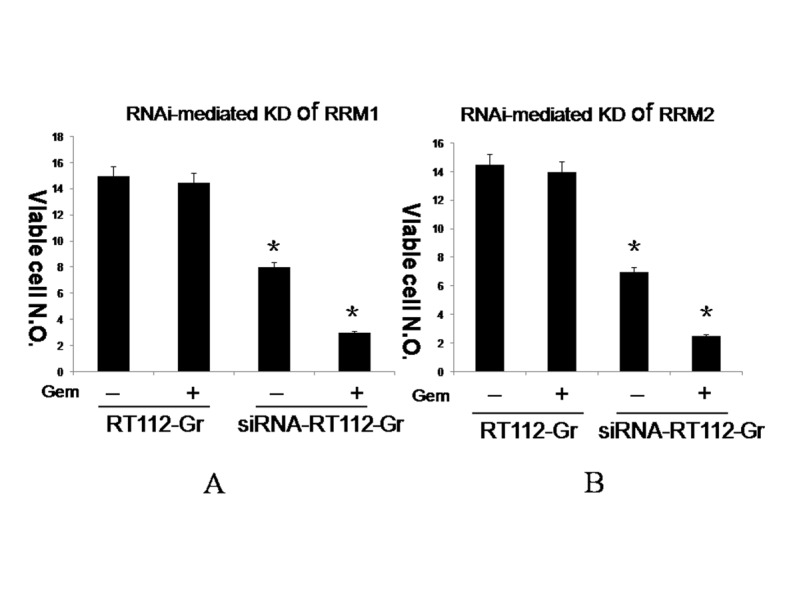
RNAi-mediated Knockdown of RRM1/2 in RT112-Gr bladder cancer cells.RT112-Gr cells were left untreated or were treated with 45nM Gemcitabine (GEM), RNAi-mediated Knockdown of RRM1 (A) and RRM2 (B) in RT112-Gr bladder cancer cells were left untreated or were treated with 45nM Gemcitabine (GEM). Seventy-two hours later viability was analyzed by Trypan blue staining. RNAi-mediated Knockdown of RRM1 (A) and RRM2 (B) +GEM, inhibiting tumor effect is the best among the four groups. Quantification of each value is from triplicate independent experiments. (p < 0.01).